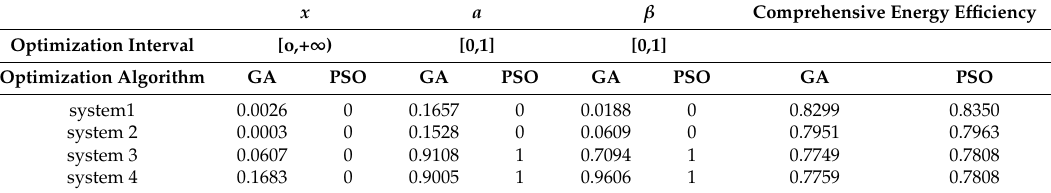
Table 3. System optimization